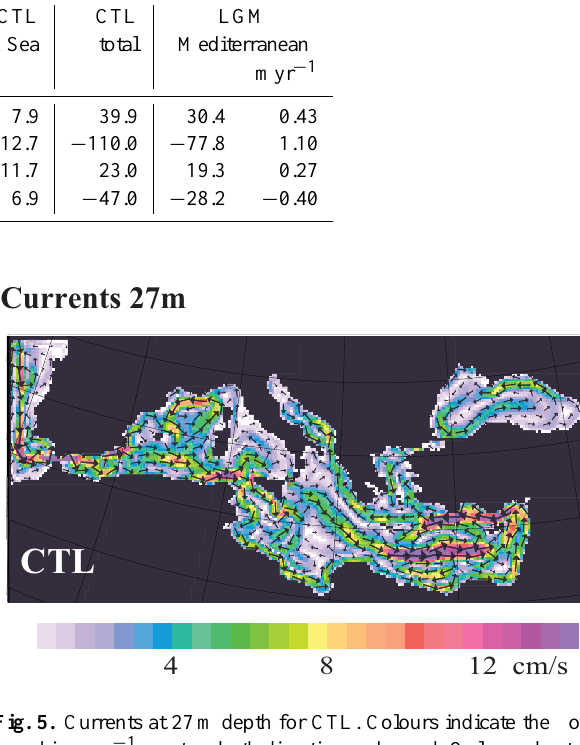
Table 1. Hydrological budget of the Mediterranean. Numbers are given in 1000m 3 s − 1 unless specified explicitely on top of the column. Numbers in myr − 1 are basin averaged fluxes. CTL CTL CTL